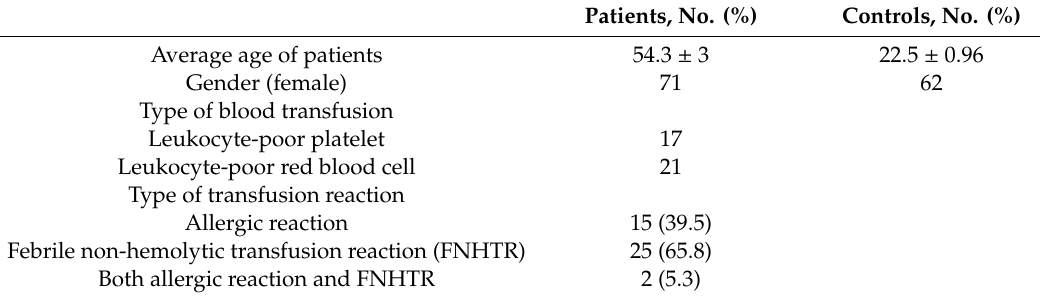
Table 2. Characteristics of patients ( n = 38) with transfusion reaction (TR) after transfusing leukoreduced blood components and healthy controls ( n = 36).